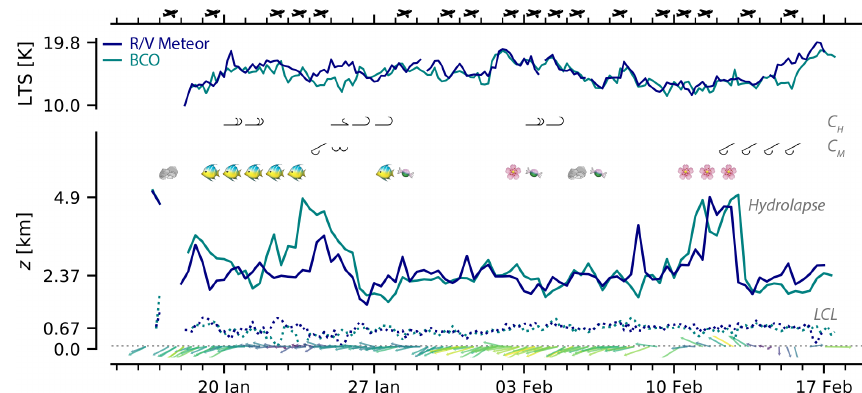
Figure 8. Synoptic overview of period and region of intensive aircraft measurements. Plotted are the lower-tropospheric stability (LTS), the height of the hydrolapse, the lifting condensation level (LCL), and the wind vector averaged over the lower 200m. Winds are 12h median values; other quantities are resampled at a 4h interval, with median values plotted, except for the LCL, where minimum values are plotted. For the wind vectors the maximum and minimum wind speeds are 12.3 and 2.0ms − 1 , respectively. Tick marks denote maximum and minimum LTS, maximum and median height of Meteor hydrolapse, and mean height of the LCL ( Meteor ). Also shown are days when aircraft with dropsondes were flying, and the synoptic cloud observations of mid-level ( C M ) and high ( C H ) clouds with the associated WMO cloud symbol (Table 14 of 2017 World Meteorological Organization Cloud Atlas, https://cloudatlas.wmo.int/en/home.html, last access: 20 December 2020) that predominated for that day. Cloud types are taken from the Barbados Meteorological Service SYNOP reports. Days on which a mesoscale pattern of shallow convection, following the classification activity of Schulz et al. (2021), was readily identified are indicated by the emojis for fish, sugar (candy), flowers, or gravel (rocks).